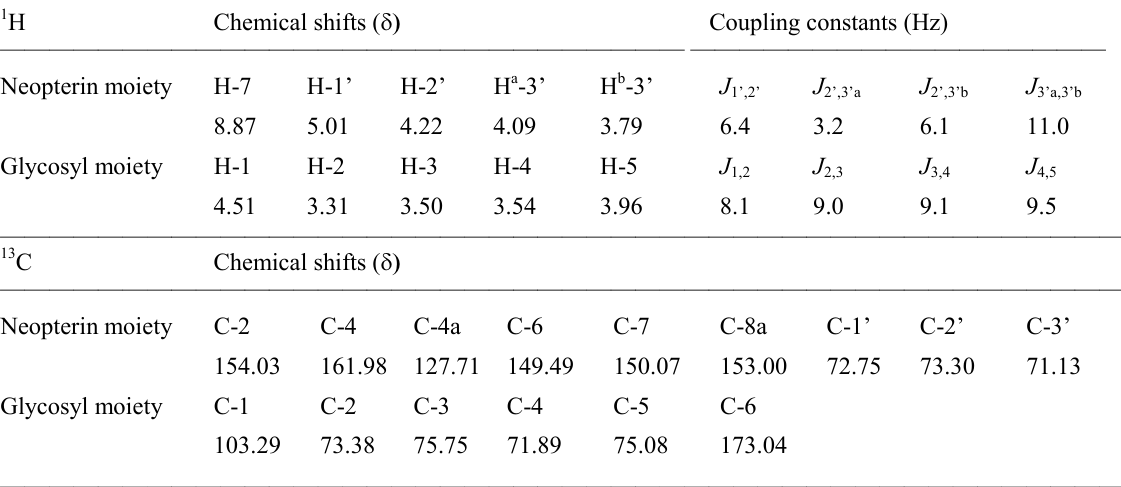
Chemical shifts ( δ)